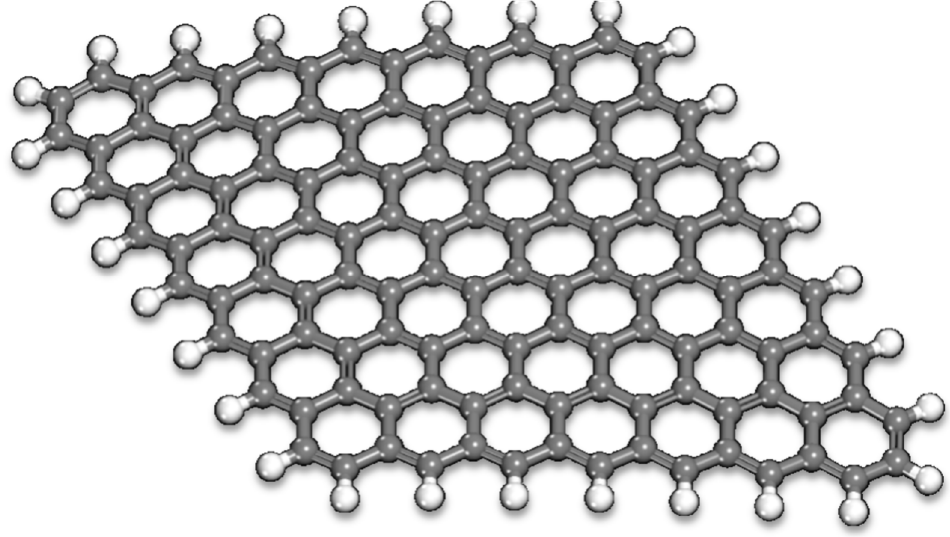
Figure 2. Optimized structure of the G model used in the adsorption studies (C—grey and H—white spheres).